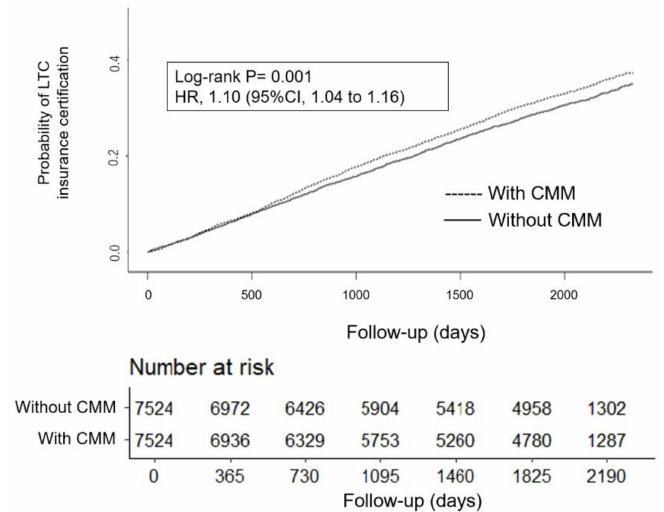
Figure 3. Cumulative incidence curve for overall care needs between patients with the CMM group and patients without the CMM group. Confidence interval (CI), complex multimorbidity (CMM); hazard ratio (HR), long-term care